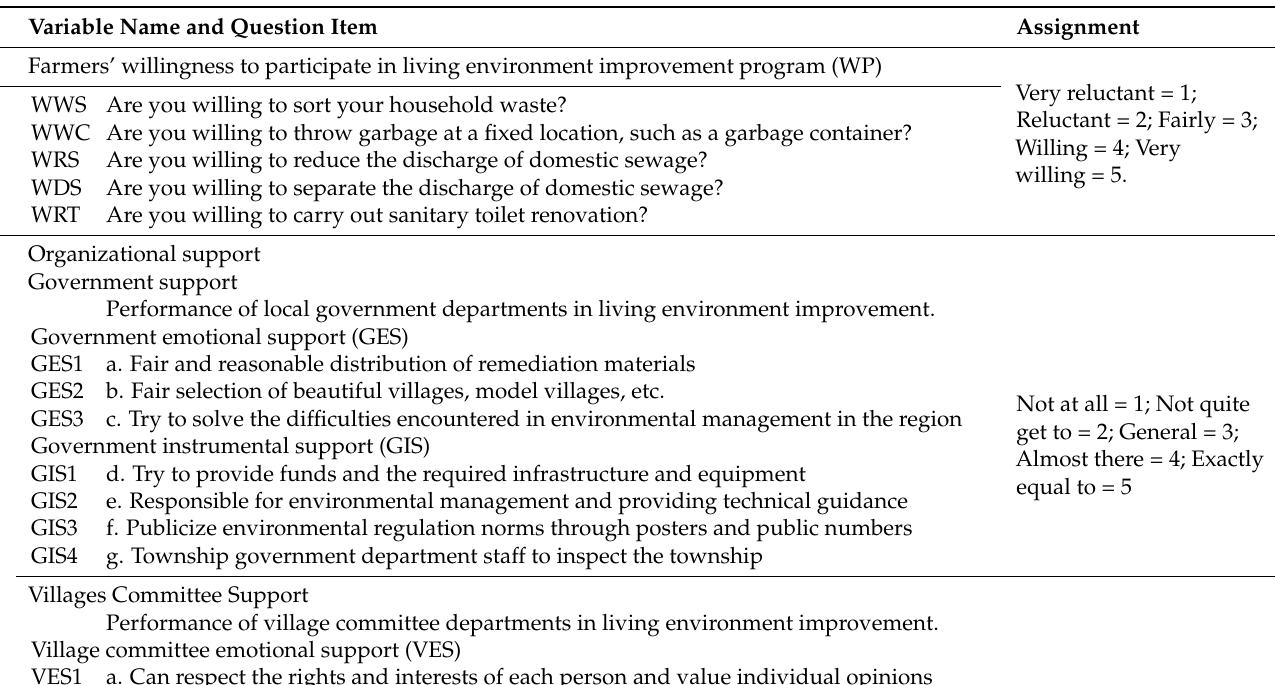
Table 2. Meaning and assignment of